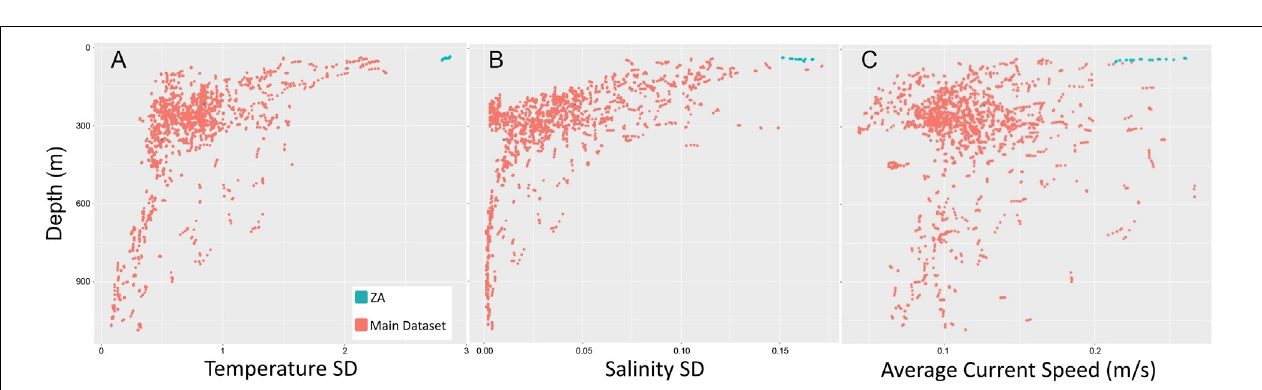
FIGURE 3 | A cluster dendrogram visualizing the TWINSPAN analysis and possible dominant environmental drivers for splits after various ordinations. The letters A–ZA correspond to the putative biotopes described in Table 2 . The inserted map shows the locations of samples of the five main groups identified at the third division level. The colors on the map correspond to the colors in the dendrogram.